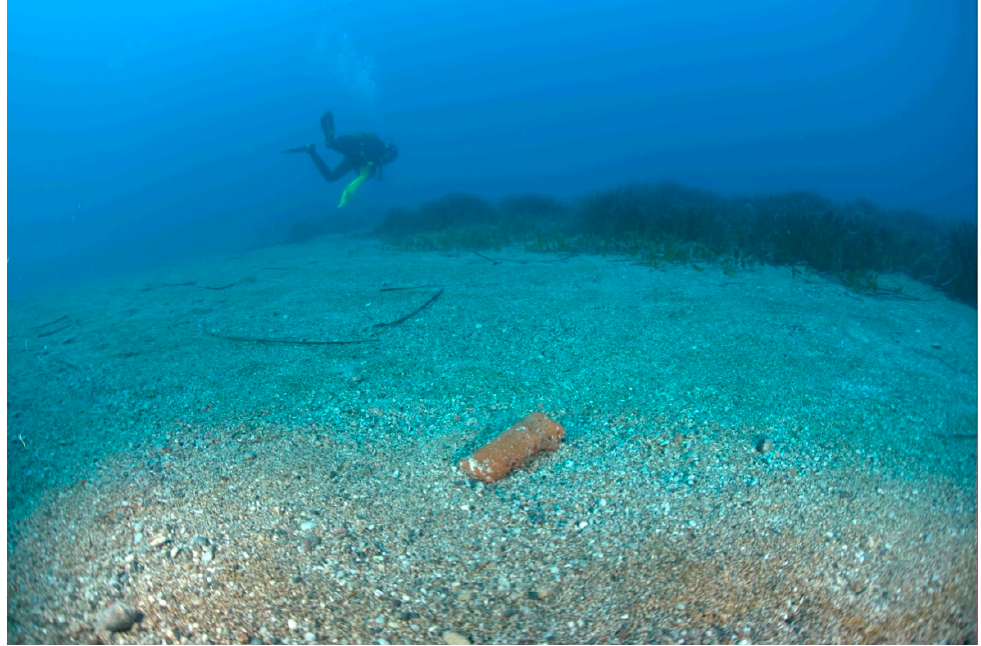
Figure 2. Collecting site at 24 m depth, besides a Posidonia bed, with coralline algal debris constituting most of the substratum.